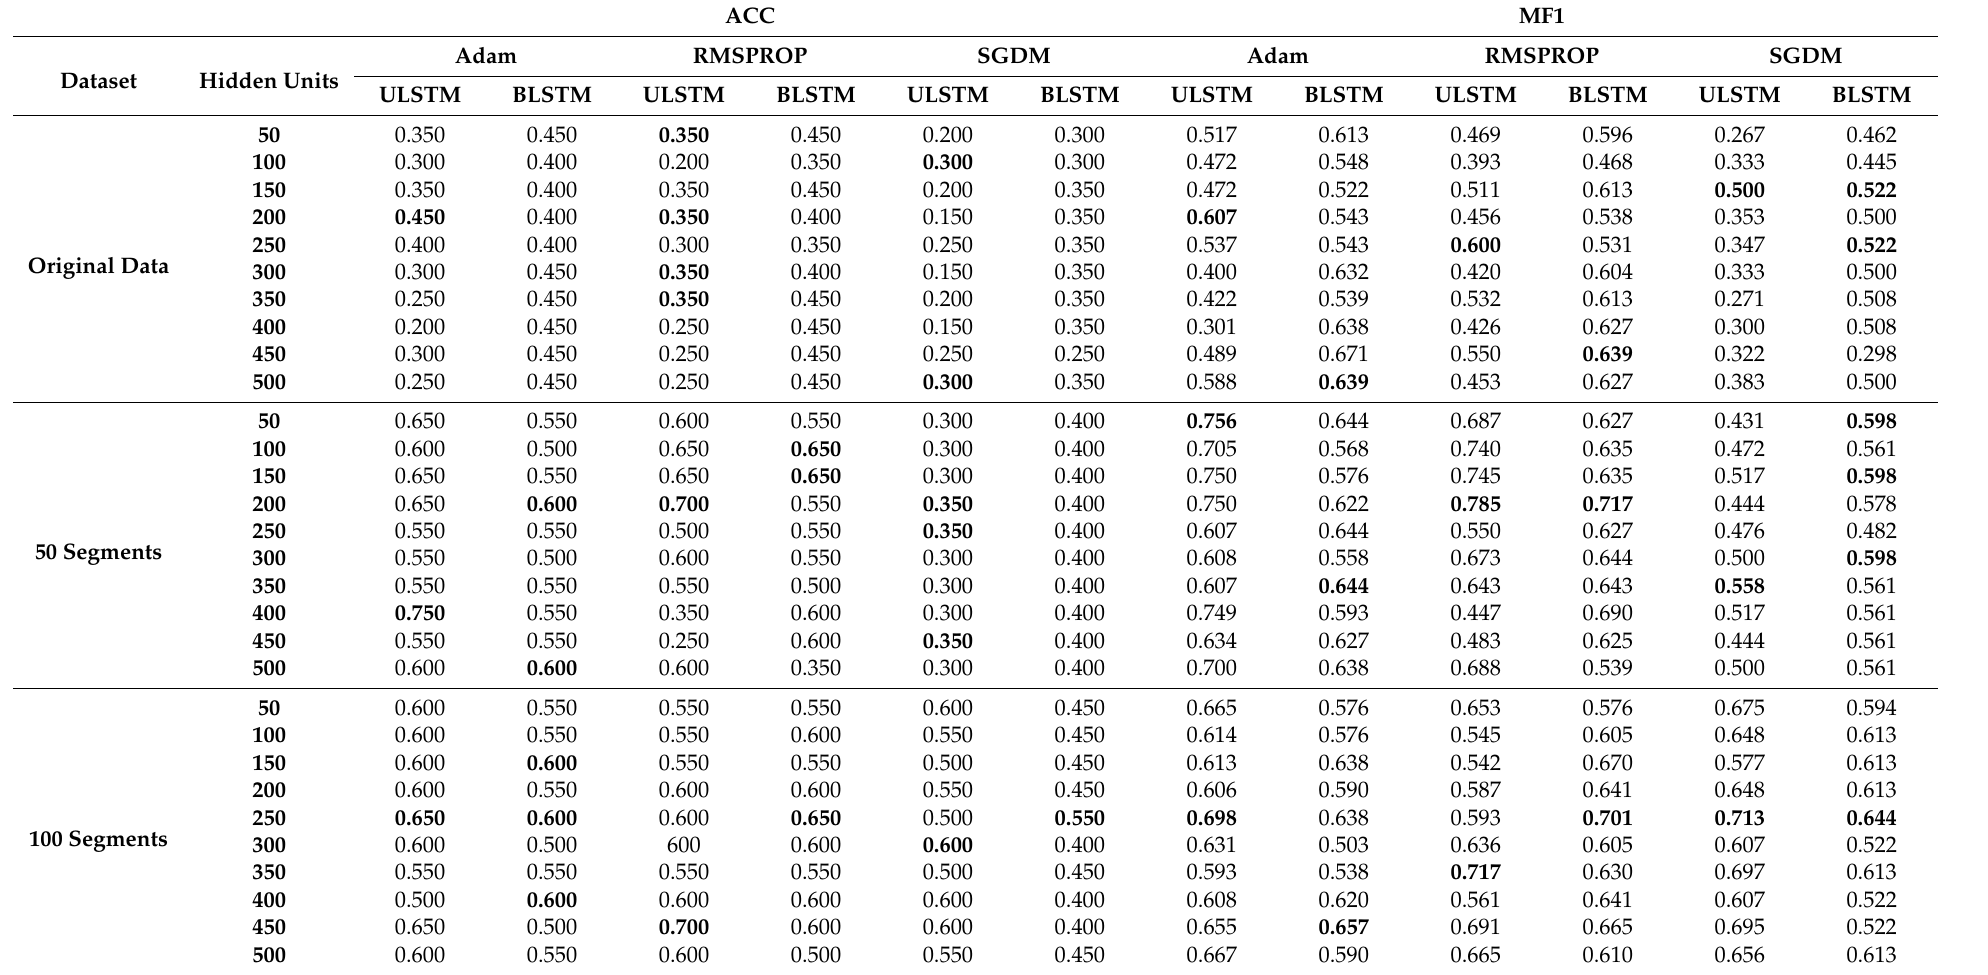
Table 13. Performance metrics of the OD test (control) data from the networks trained with the 35-mer Oestrdiol dataset. ACC MF1